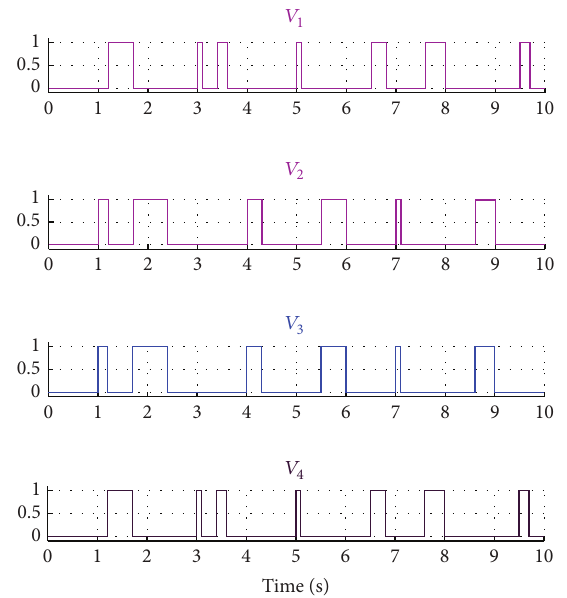
Figure 8: Excitation signal used in model validation. The pulses shown in figure correspond to logic signals used for actuator control (0 is closed valve, 1 is open valve, and 𝑉 1 , 𝑉 2 , 𝑉 3 , and 𝑉 4 are valves).